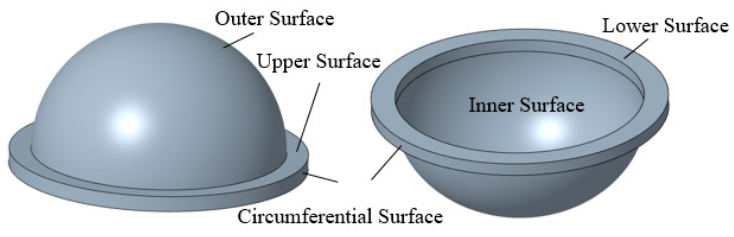
Figure 1. The spherical shell part.